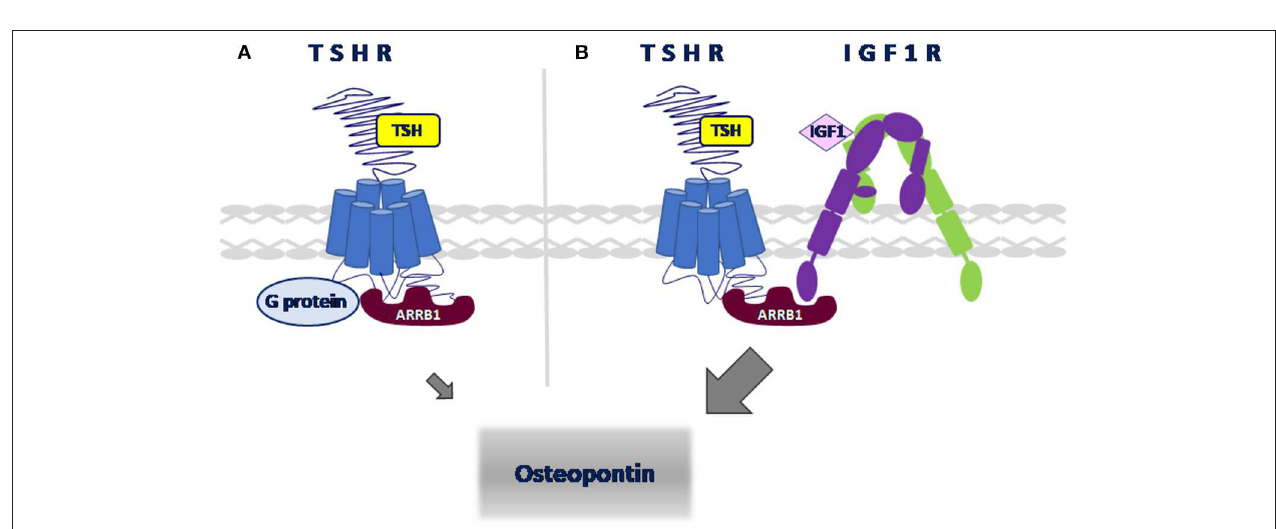
FIGURE 5 | Model of signaling pathways leading to OPN secretion in U2OS-TSHR cells. (A) TSHR-mediated upregulation of OPN. TSH-induced OPN secretion is regulated via G α i and β -arrestin 1-mediated signal transduction pathways. (B) β -arrestin 1 scaffolds TSHR and IGF1R to enable crosstalk. TSH and IGF1 synergistically upregulate OPN secretion. β -arrestin 1 stabilizes the receptor complex which enables TSHR/IGF1R